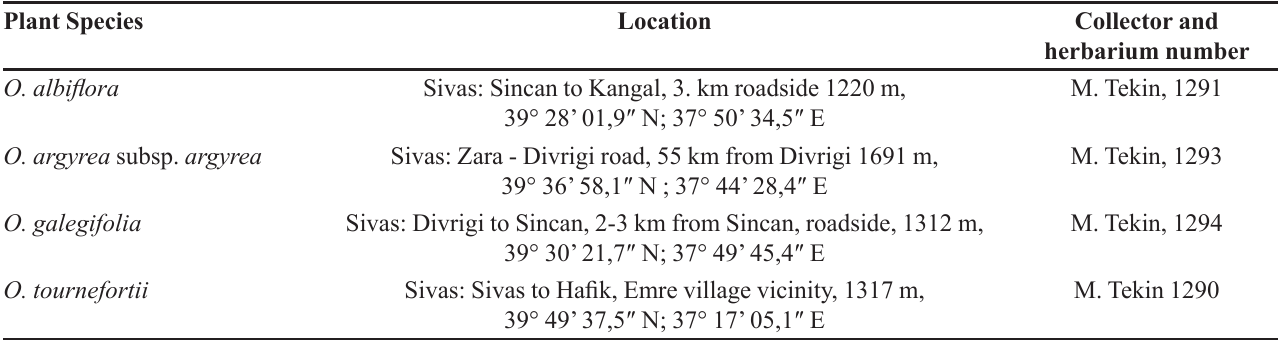
TABLE I - List of Onobrychis species collected for the study Plant Species Location Collector